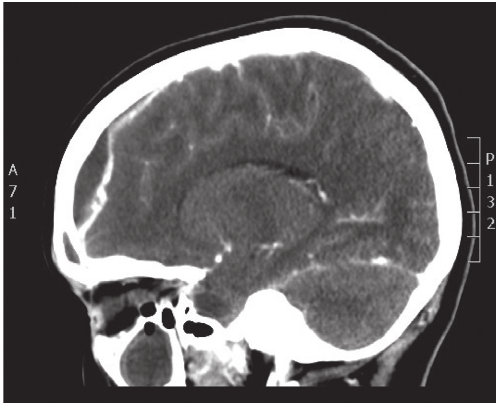
Figure 8: Sagittal brain CT scan showing a subdural empyema.